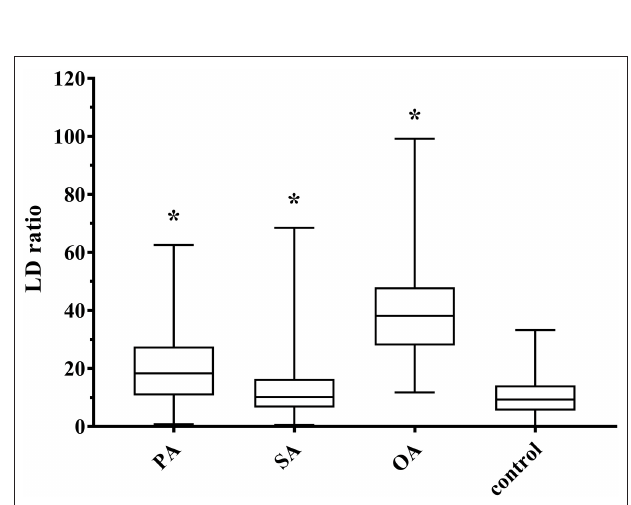
FIGURE 6 | Boxplot (median; 25th to 75th percentiles; min to max) of lipid droplet (LD) ratio (LDs per cell/100 µ m 2 nucleus surface area). Asterisks represent significant difference between treatment and control ( p < 0.05). PA, palmitic acid ( N = 221); SA, stearic acid ( N = 187); OA, oleic acid ( N = 216); control ( N = 197); N , the number of evaluated